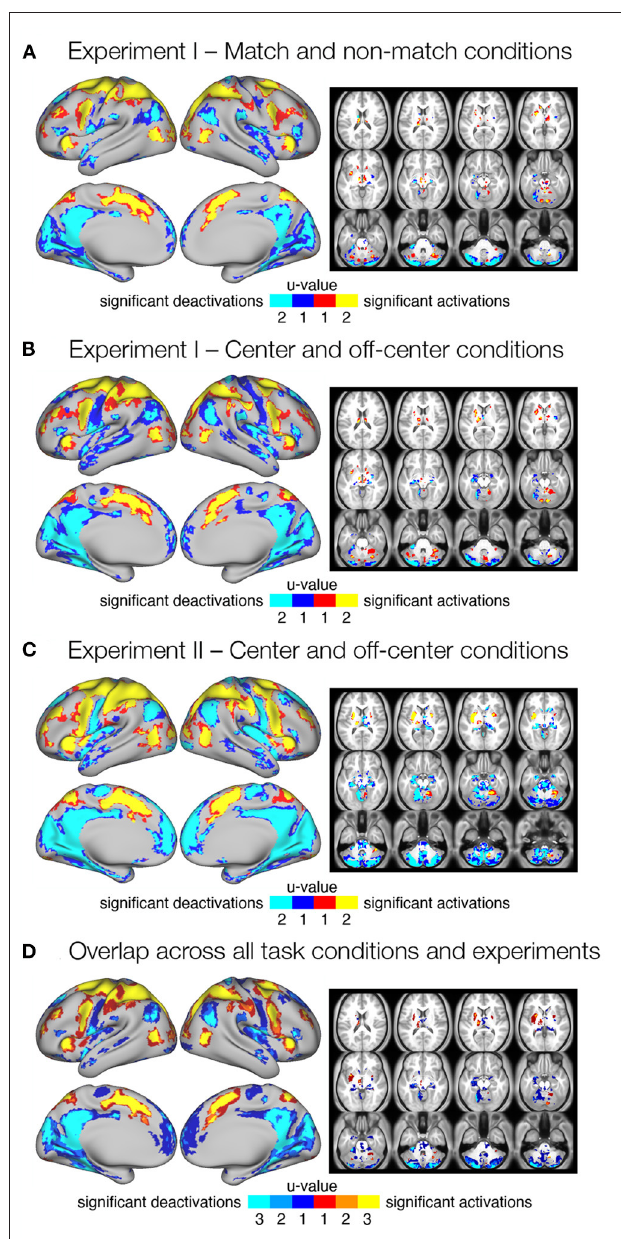
FIGURE 2 | Significant delay-related responses. (A–C) Results of conjunction analysis showing significant delay-related activations (red-yellow) and deactivations (blue-cyan) in both (u = 2) or one (u = 1) of the task conditions for different task types and experiments, in particular (A) match and non-match conditions in Experiment I, (B) center and off-center conditions in Experiment I, and (C) center and off-center conditions in Experiment II. Shown are regions that were identified as significant at FDR corrected pooled q < 0.05. (D) Consistent delay-related activations and deactivations across all